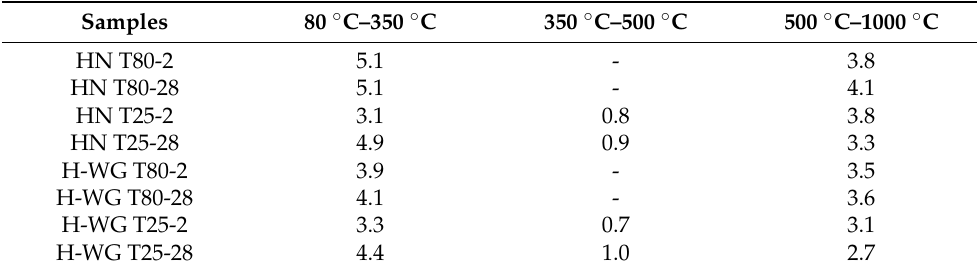
Table 6. TG-mediated weight loss (wt%) in hybrid